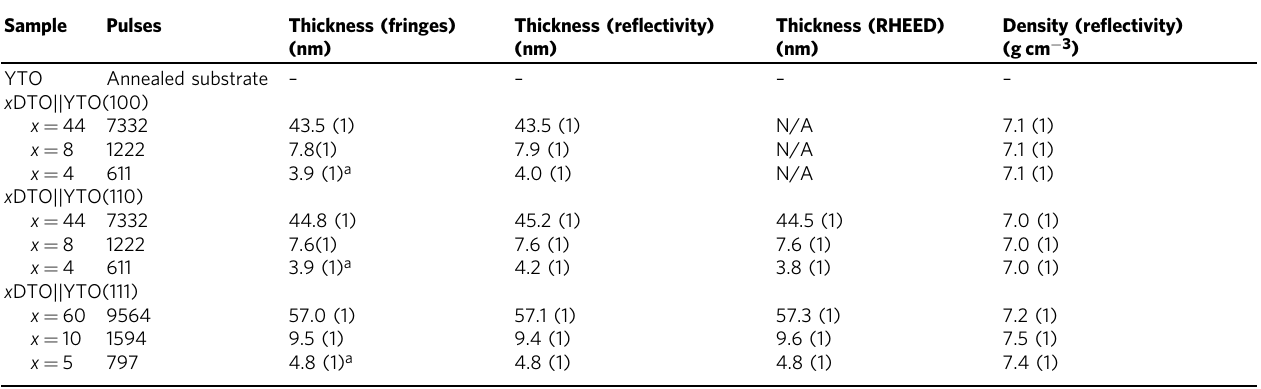
Table 1 x DTO||YTO( hkl ) list of samples, with x indicating the number of monolayers and ( hkl ) the out-of-plane growth